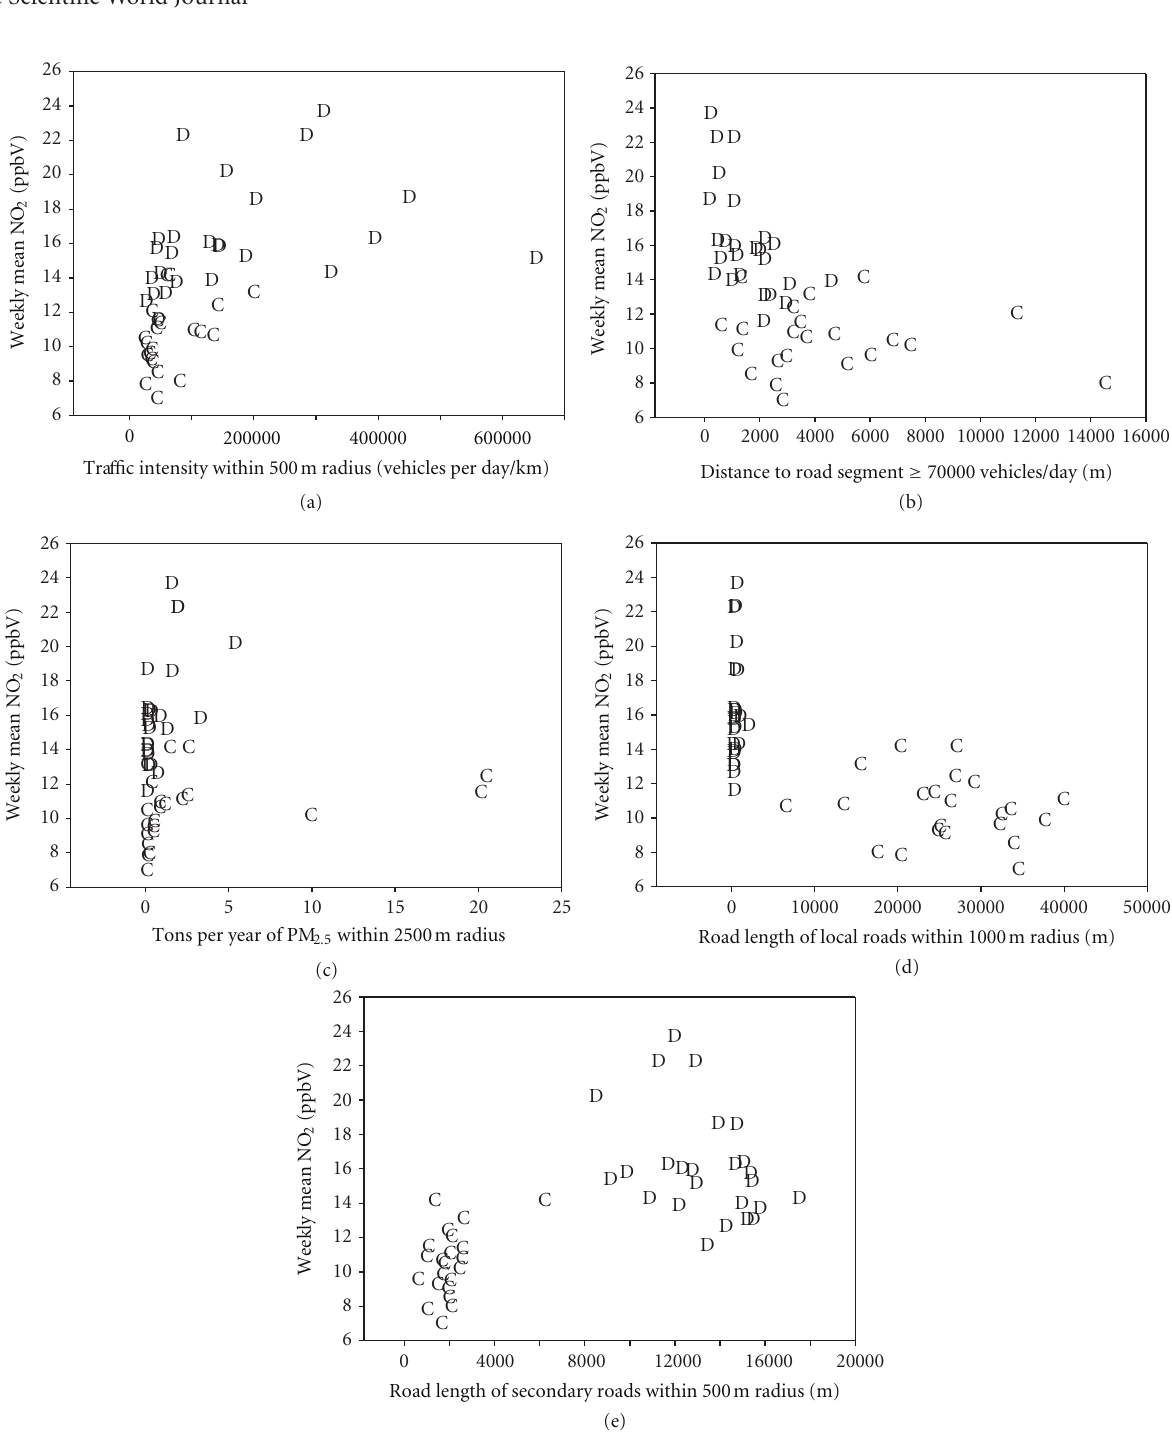
Figure 3: NO 2 concentration using common variables in Detroit (D) and Cleveland